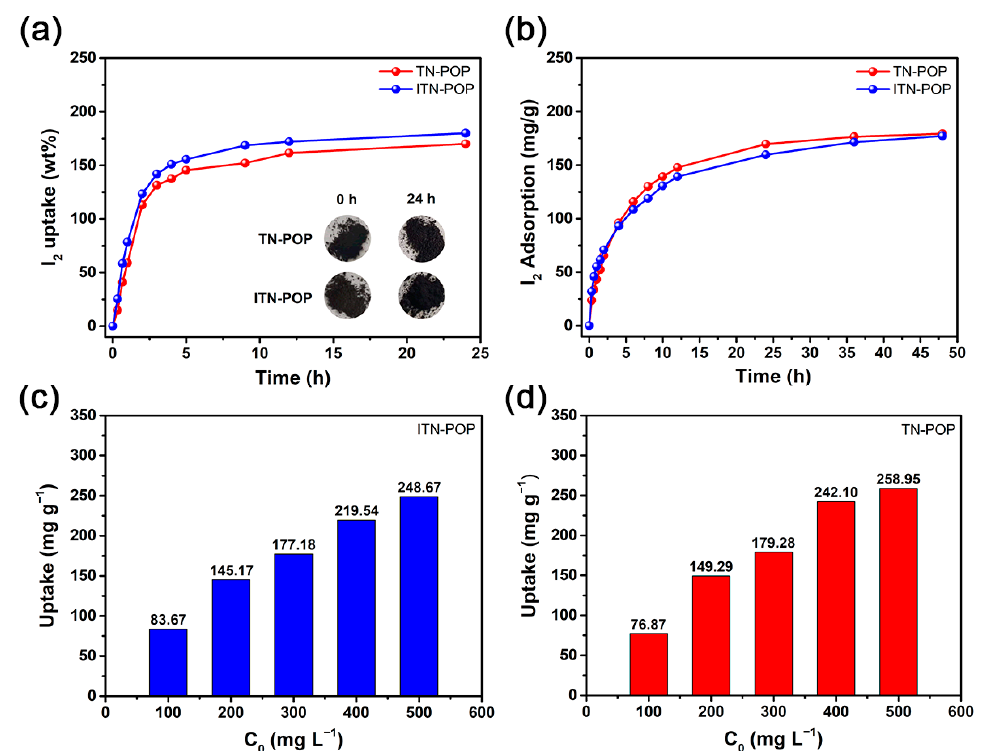
Figure 5. ( a ) Gravimetric uptake of iodine as a function of time at 348.15 K. Inserted photographs show the color change when ITN-POP and TN-POP were exposed to iodine vapor for 24 h; ( b ) Iodine adsorption by ITN-POP and TN-POP in cyclohexane solutions (300 mg L − 1 ); ( c , d ) Kinetic studies of iodine adsorption by ITN-POP ( c ) and TN-POP ( d ) in cyclohexane solutions with different concentrations (100–500 mg L − 1 ).